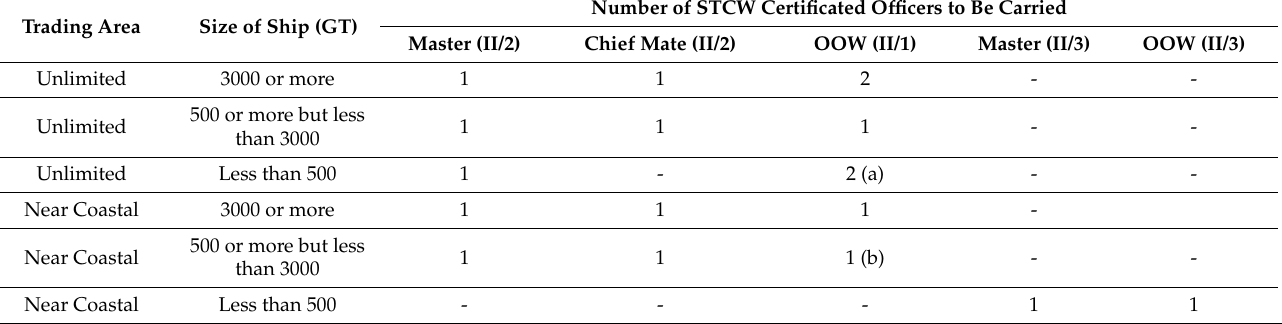
Table 1. Flag state safe manning requirements 1